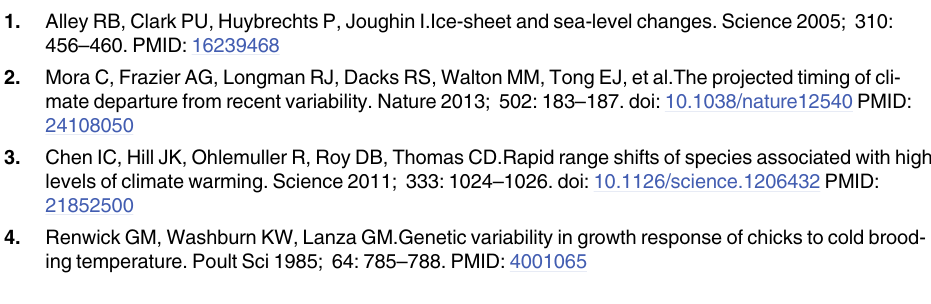
S1 Fig. Effect of CMCC on AMPK β and AMPK γ subunits in young broiler chickens. Rela- tive expression of AMPK β 1/ β 2 and AMPK γ 1/2/3 in the brain (a), liver (b), and muscle (c) was measured by qPCR using 2 - ΔΔ Ct method. Data are mean ± SEM (n = 6). (cid:2) Indicate a significant difference between cold and the control group ( P <